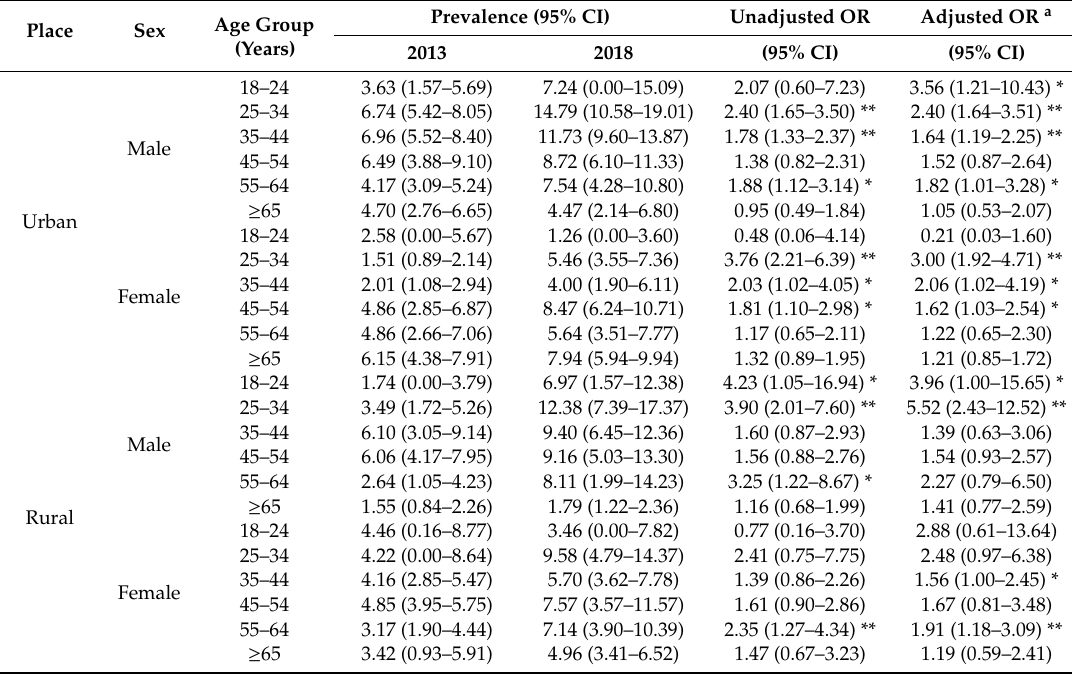
Table 3. Place-, sex- and age-specific obesity prevalence rates among inhabitants between 2013 and 2018 in Hunan Province,